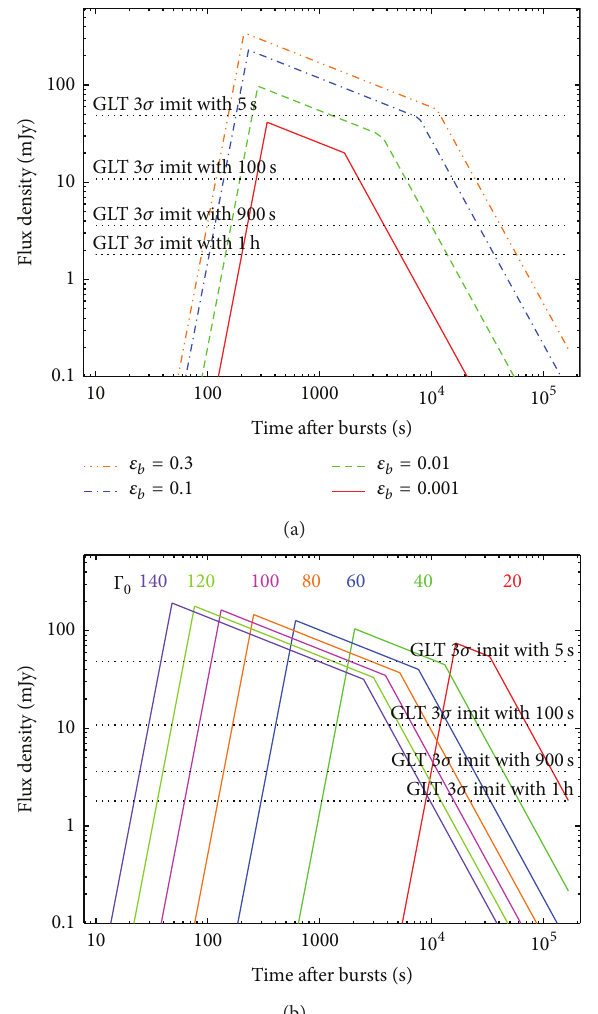
Figure 6: (a) Expected RS light curves in the 230 GHz band with (0.001, 0.01, 0.1, and 0.3). Other physical parameters are various 𝜖 𝐵, RS = 0.01 . fixed as 𝑧 = 1 , 𝐸 = 3 × 10 52 , Γ = 80 , 𝑛 = 1 , 𝜖 𝑒 = 0.3 , and 𝜖 𝐵, Figure 8: Expected RS (dashed-dot) and FS (dashed) light curves FS (b)ExpectedRSlightcurvesinthe230 GHzbandwithvariousinitial in the 230 GHz band at 𝑧 = 0.3 , 0.5, and 0.7 with 𝐸 = 3 × 10 52 erg, Lorentz factor Γ 0 . Other physical parameters are 𝑧 = 1 , 𝐸 = 3×10 52 , = 0.3 ,and 𝜖 = 0.01 .Solidlinesindicatethe 𝑛 = 1 cm −3 , 𝑝 = 2.1 , 𝜖 𝑒 𝐵, FS = 0.3 , 𝜖 = 0.03 , and 𝜖 = 0.01 . The expected GLT 3- 𝜎 𝑛 = 1 , 𝜖 𝑒 𝐵, RS 𝐵, FS total of RS and FS. GLT has also enough sensitivity to characterize limits with 900 s and 1h exposure are indicated with dotted lines in the FS components for nearby ( 𝑧 ≲ 0.7 )GRBs. The expected GLT both panels. 3- 𝜎 limits with 1 h and 3 h exposure are indicated with dotted